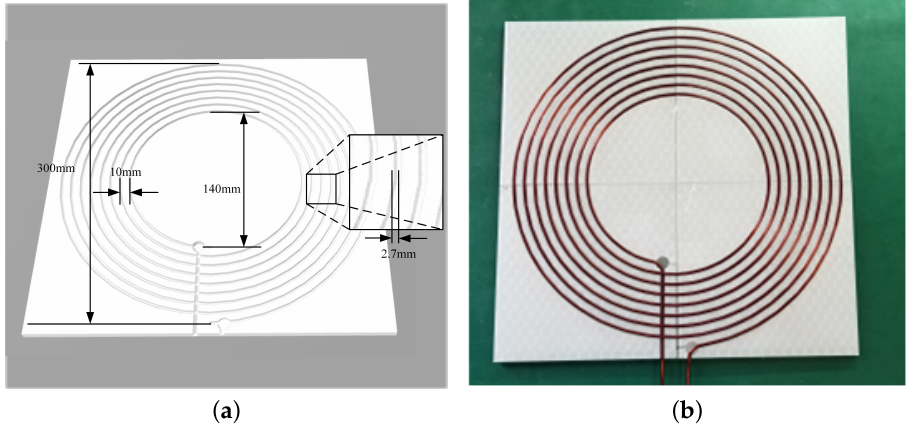
Figure 4. Planar circular spiral coil: ( a ) Rendering graph of the base plate; ( b ) photograph of the